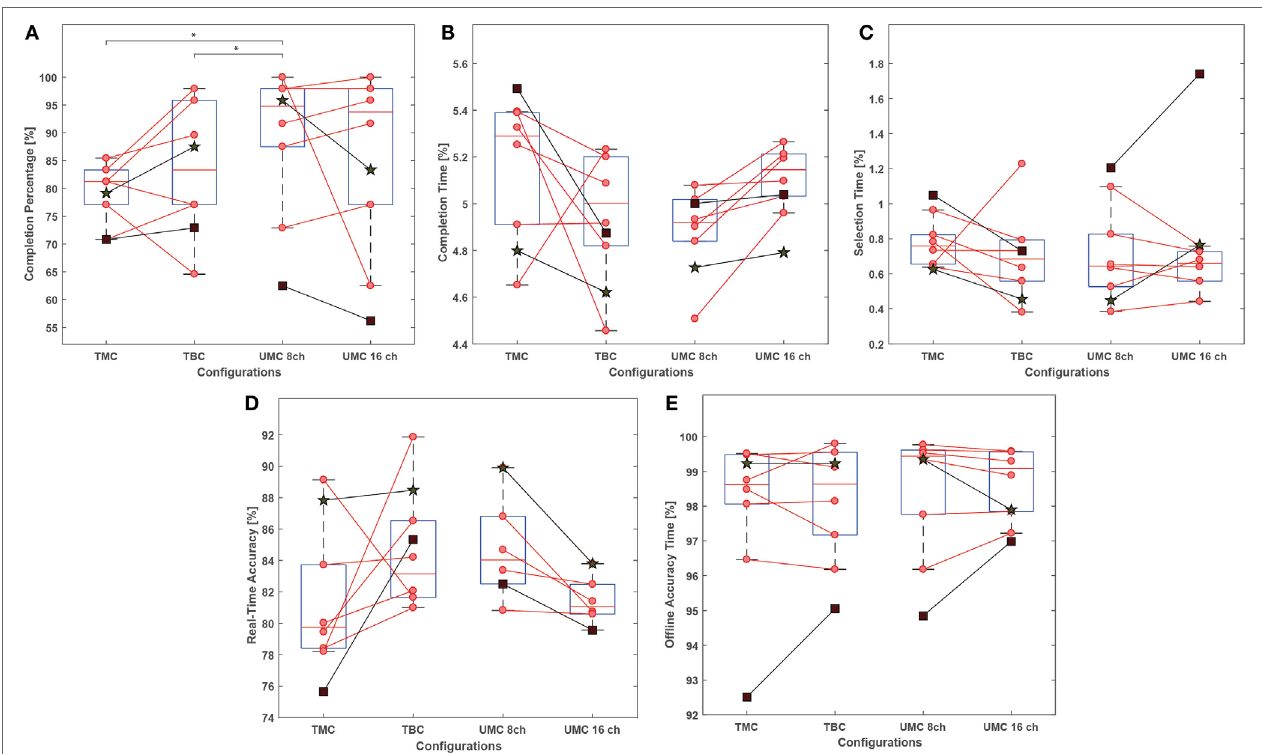
FigUre 5 | Box plots presenting the results of the comparison of the three electrode configurations in terms of real-time metrics relative [i.e., (a) completion percentage, (B) completion time, (c) selection time, (D) real-time accuracy] and (e) offline accuracy. The boxplots represent only the data relative to non-amputated subjects. The line in the center of the boxes indicates the location of the median, the upper edge indicates the third quartile, the bottom edge represents the first quartile, and the whiskers indicate the data range. Along with every boxplot, it is possible to the mean value for each subject. Red dots represent non-amputees, while the square and a star marker represent the data points for the transtibial and the transfemoral amputee subject, respectively. Statistical significance ( p < 0.05) is marked by the